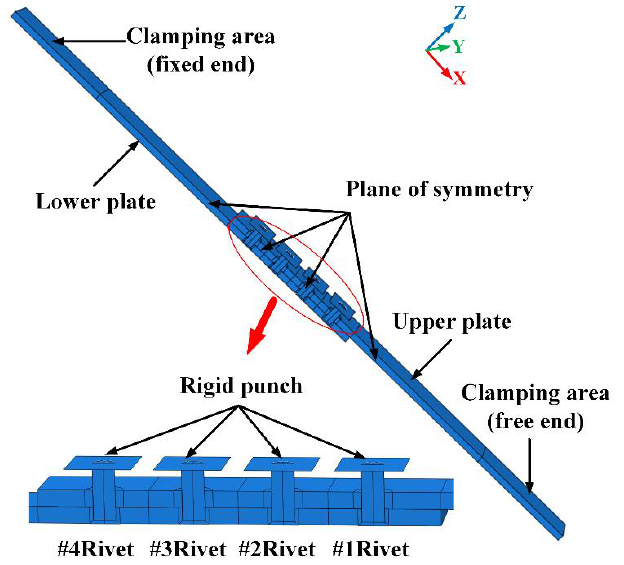
Figure 6. The axisymmetric model of riveted lap joint. There are two kinds or rivet diameters (4 mm and 5 mm) and three kinds of rivet pitches (16 mm, 18 mm, and 20 mm).